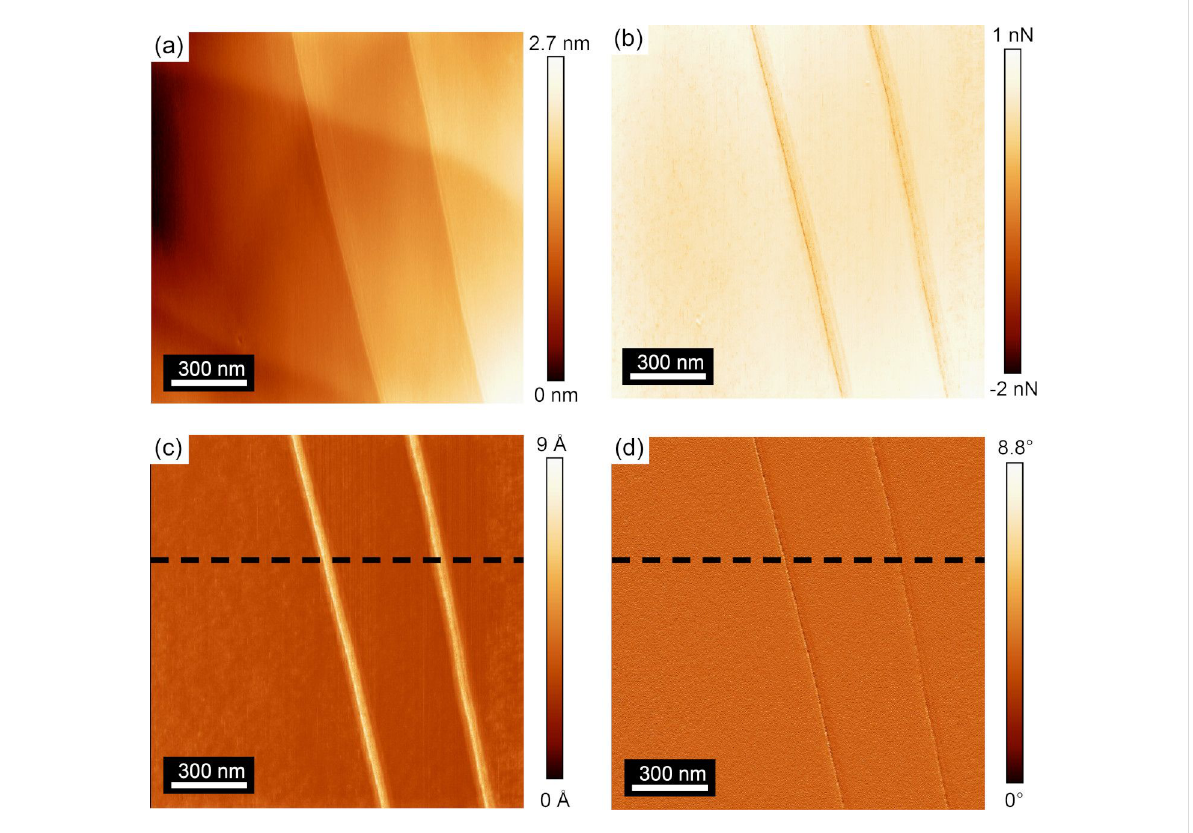
Figure 4: (a) Topographic and (b) lateral force maps acquired in the forward scan direction on uncovered and covered steps of an HOPG surface from the CR experiment. The simultaneously recorded (c) amplitude and (d) phase maps (modulation frequency of 82 kHz) show contrast only